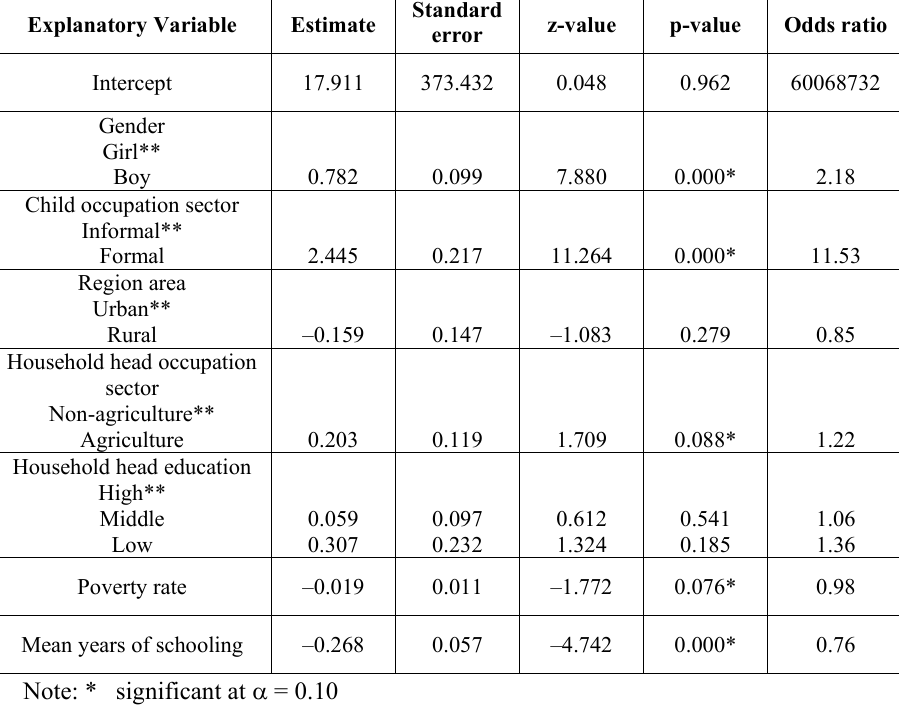
Table 2. Results of parameter estimation and partial